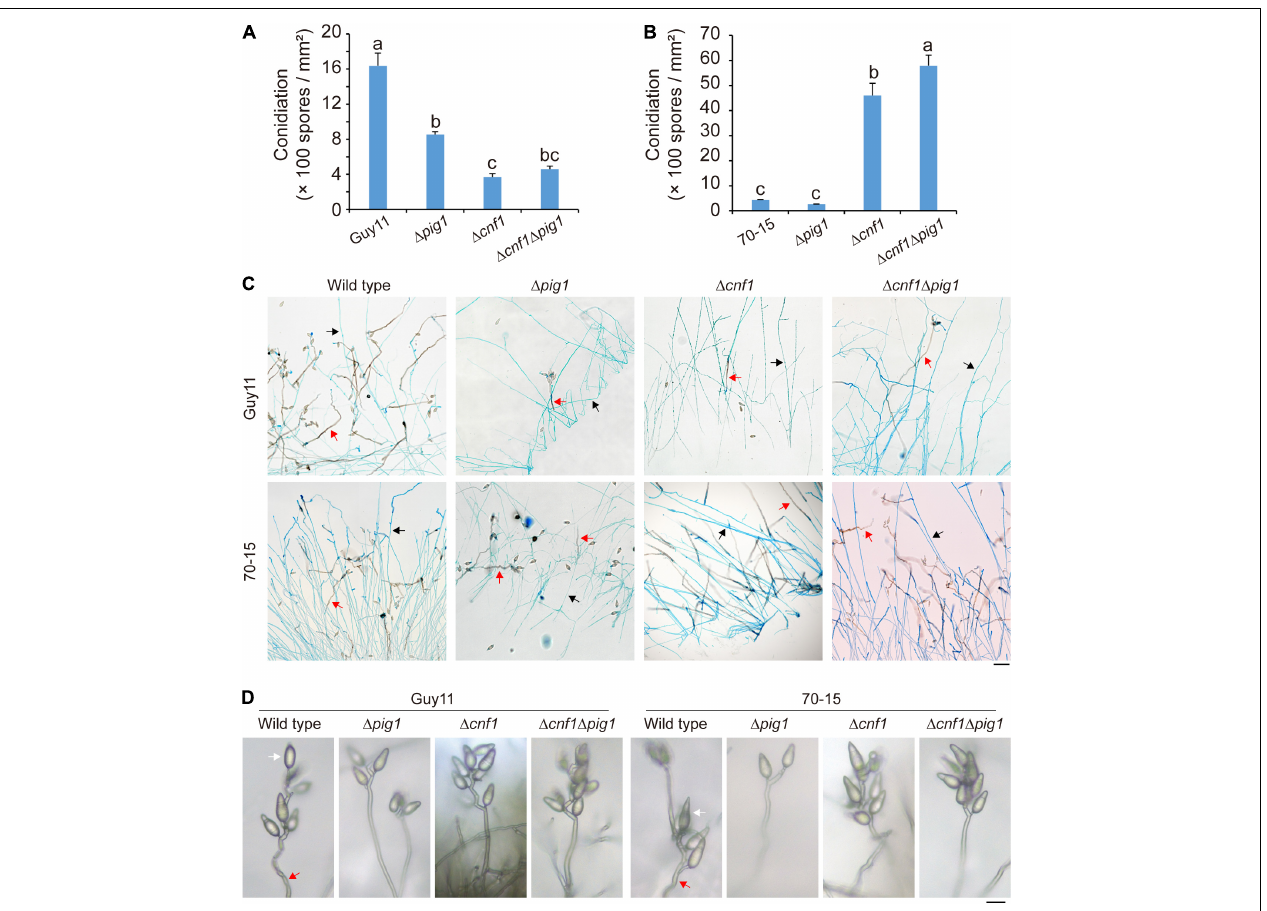
FIGURE 3 | The different functions of Pig1 and Cnf1 on conidiation in M. oryzae strains Guy11 and 70-15. (A) Spore production of the wild-type Guy11 and its derived mutants ( (cid:49) pig1 , (cid:49) c nf1 (cid:49) pig1 , and (cid:49) cnf1 ). (B) Spore production of the wild-type 70-15 and its derived mutants ( (cid:49) pig1 , (cid:49) c nf1 (cid:49) pig1 , and (cid:49) cnf1 ). Error bars represent ± SD. Different lowercase letters represent significant differences between four strains as estimated by Tukey’s HSD test ( p < 0.05). (C) Aerial hyphae and conidiophores formed by the wild-type Guy11 and 70-15, and their derived mutants ( (cid:49) pig1 , (cid:49) c nf1 (cid:49) pig1 , and (cid:49) cnf1 ). The aerial hyphae were dyed blue by lactophenol aniline blue. Red arrows indicate conidiophores, and black arrows indicate aerial hyphae. Bar = 50 µ m. (D) Conidiophores and conidia of the wild-type Guy11 and 70-15, and their derived mutants ( (cid:49) pig1 , (cid:49) c nf1 (cid:49) pig1 , and (cid:49) cnf1 ). Red arrows indicate conidiophores, and white arrows indicate conidia. Bar = 20 µ m.